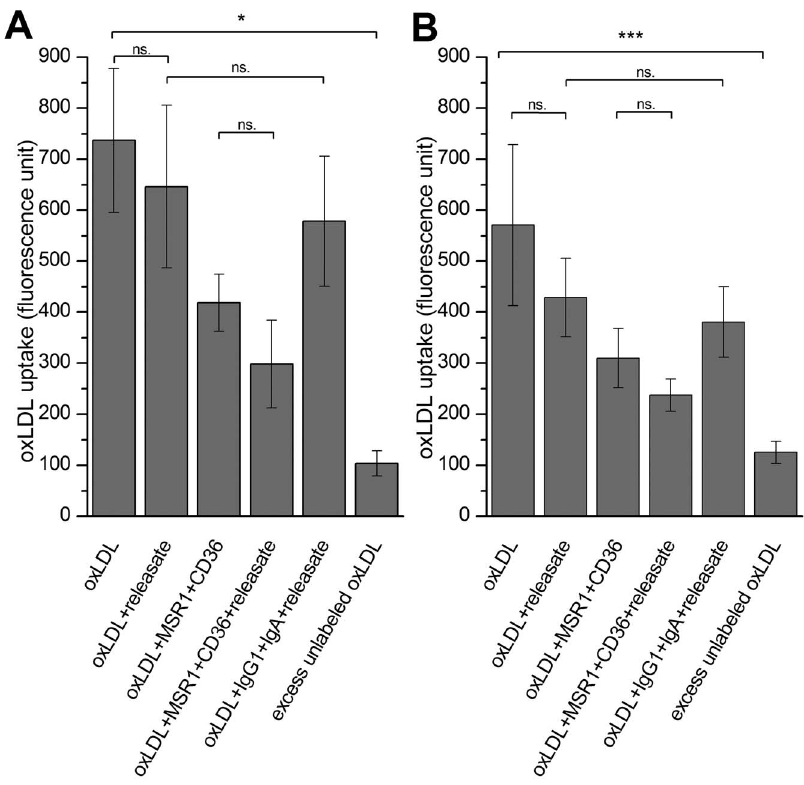
Figure 6. Effect of LAD2 and primary mast cell releasates on macrophage oxLDL uptake. Monocyte-derived macrophages were incubated for 16 h in the presence of 50 m g/ml of DiI-oxLDL and/or with LAD2 (A) or primary mast cell (B) releasate, and/or with specific blocking antibodies for CD36 and MSR1 (2 m g/ml), or with isotype control antibodies IgG1 and IgA (2 m g/ml), or with 20-fold excess of unlabeled oxLDL to determine the magnitude of the high-affinity uptake of Dil-oxLDL. DiI fluorescence was measured from cell lysates. The results are presented as means 6 SEM (n=4 donors). *p , 0.05, **p , 0.01, ***p , 0.001.